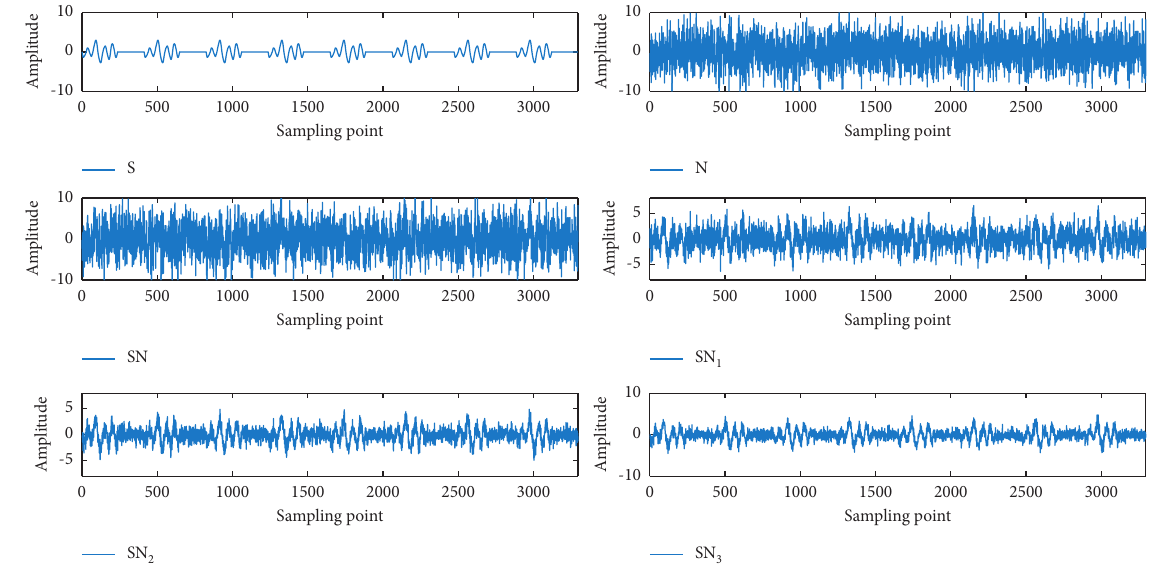
Figure 1: Diagramof DSM.Sisthetarget signal;N istheinterferencesignal;SN isa mixedsignalof SandN; SN signals obtained by superposition of 5, 15, and 20 times, respectively, using equation (1). The superposition step length L is the period of signal S.